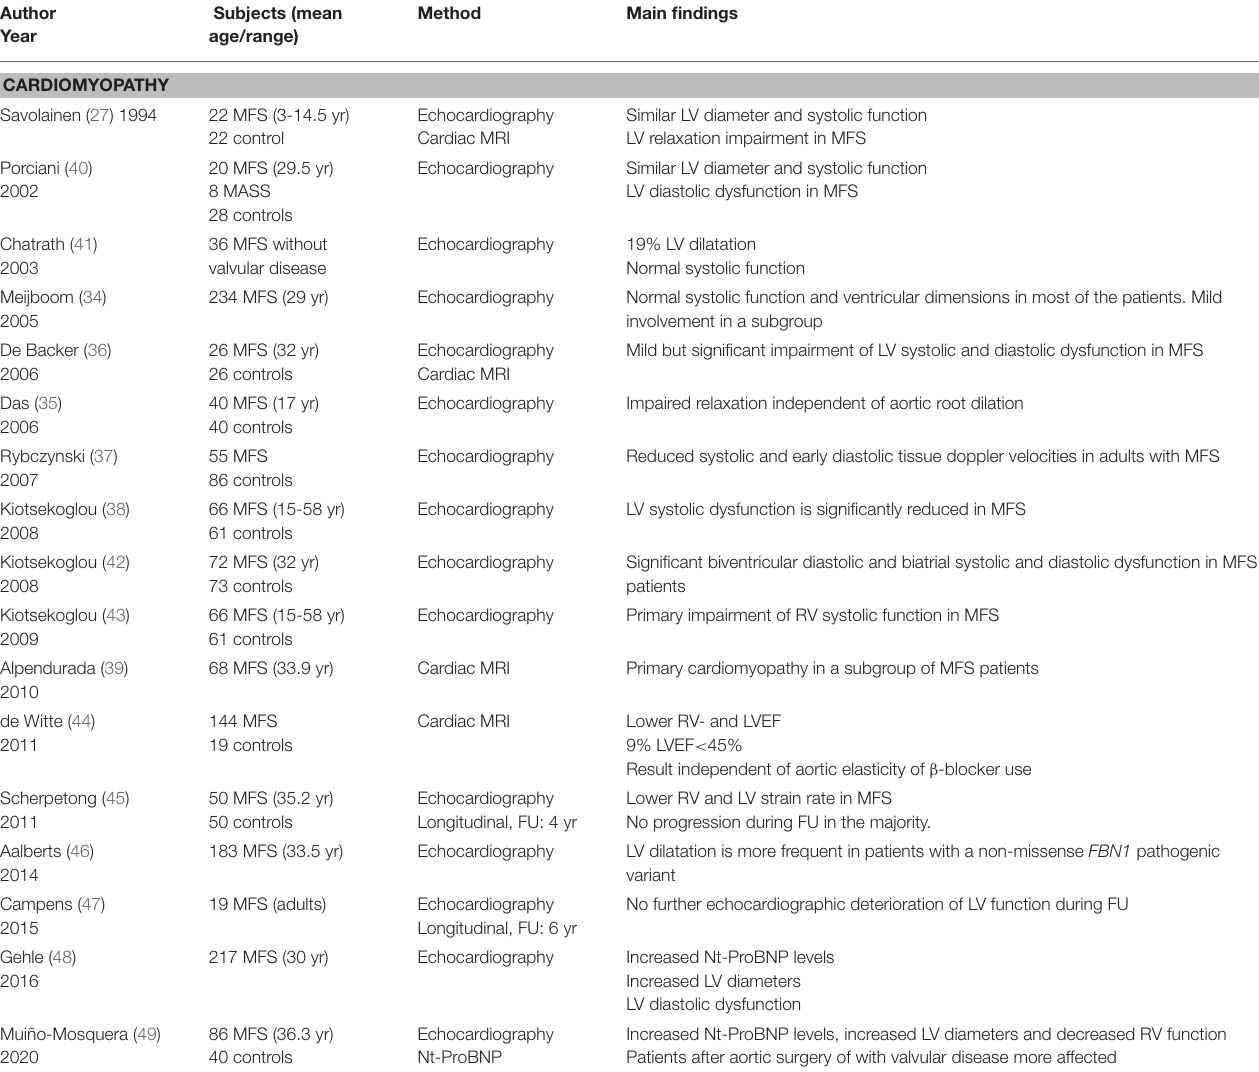
TABLE 2 | Overview of the studies assessing cardiac function in Marfan